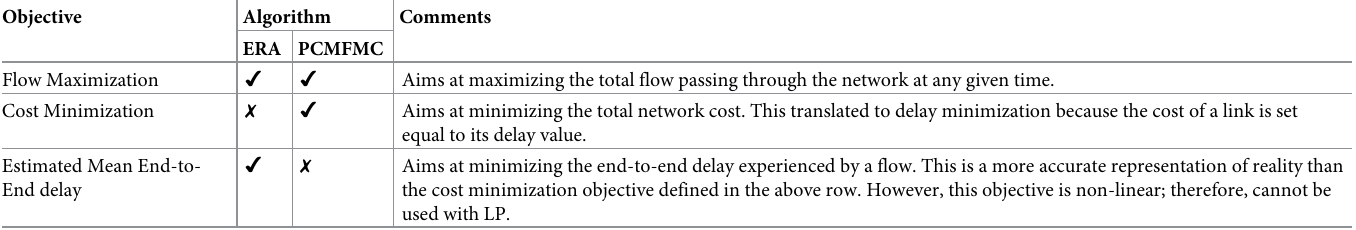
Table 1. Description and relationship between the objectives used by the ERA and PC-MFMC problem solved using LP. ✔ : Objective present in algorithm. ✗ : Objec- tive not present in algorithm.